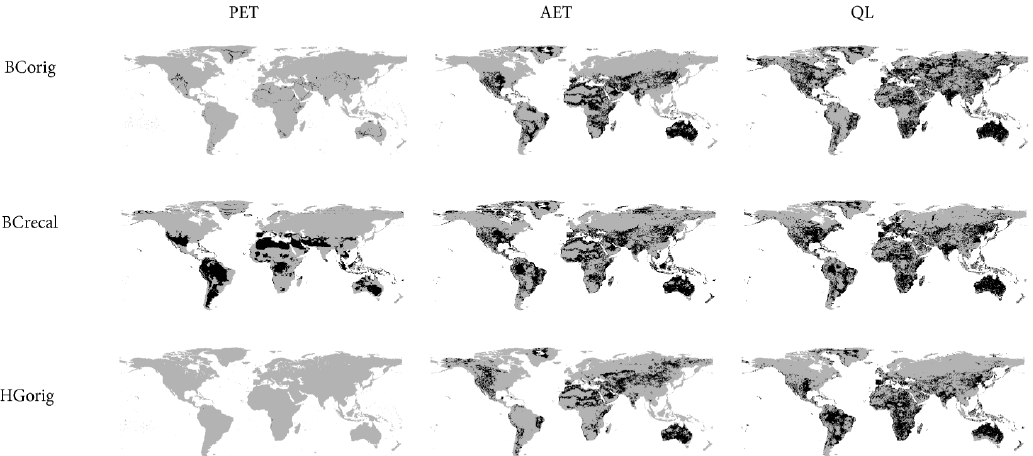
Fig. 8a. Maps showing areas where CFSR derived PET, AET and local runoff (QL) significantly deviates according to the Welch’s t-test for a significance level of 95% from CRU derived values (in grey) and areas where annual average values do not significantly deviate (in black) for the BCorig, BCrecal and HCorig